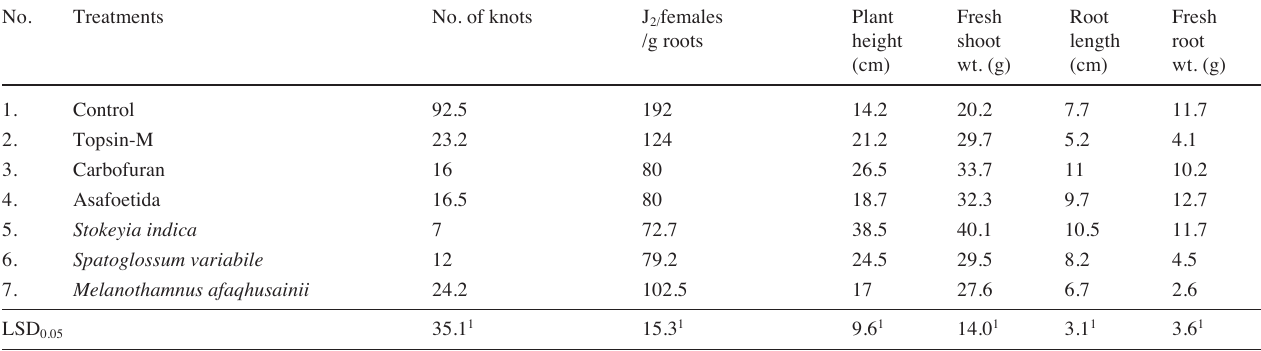
Tab. 2: Effect of asafoetida and seaweed on the infection of root knot nematode and growth of eggplant in field plot experiment. No. Treatments